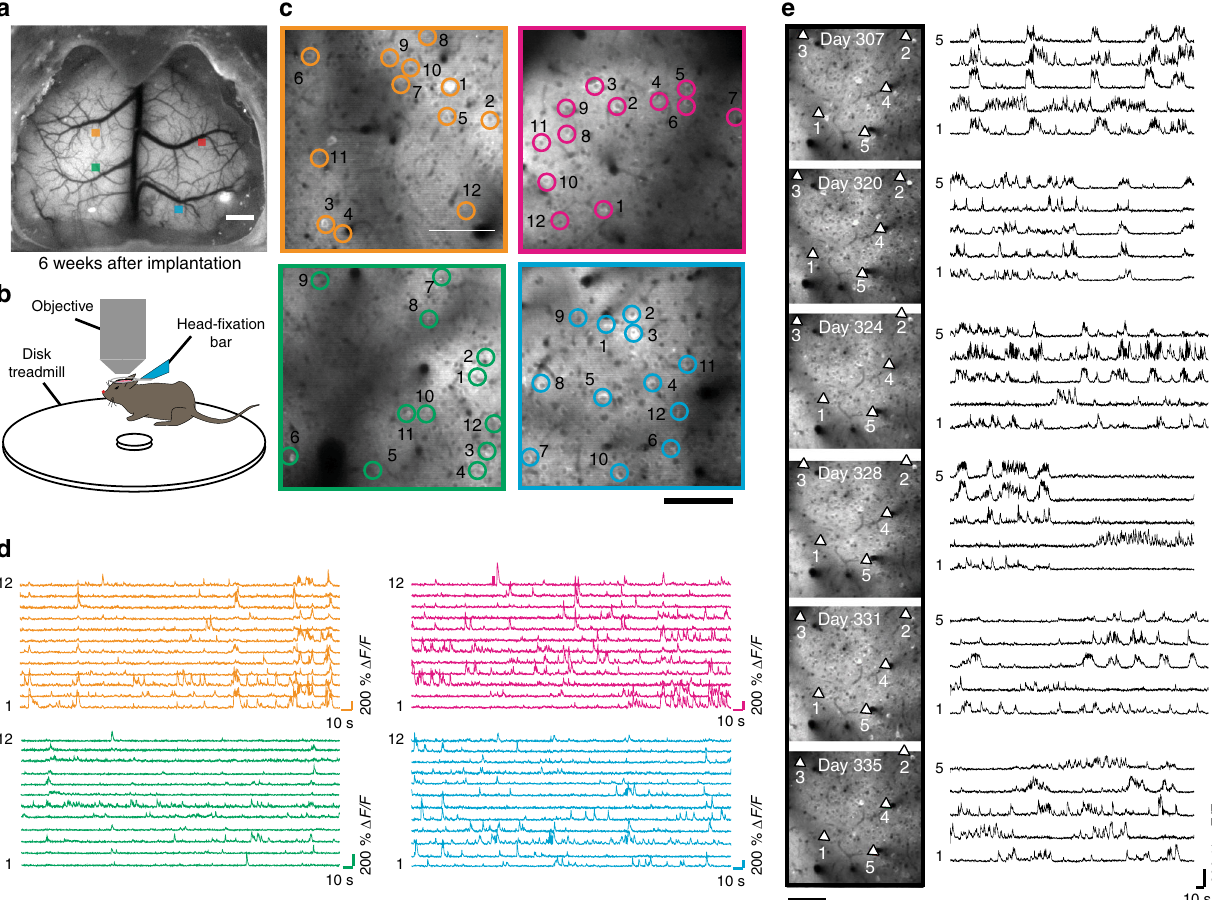
Fig. 4 Monitoring Ca 2 + activities in awake head- fi xed mice. a Wide- fi eld image of a Thy1-GCaMP6f mouse implanted with a See-Shell taken 6 weeks after implantation. Four locations indicated by the colored blocks were imaged using a 2P microscope. Scale bar indicates 1 mm. b Schematic of the mouse on the custom-designed disk treadmill used for 2P imaging. c Average intensity images calculated from 5-min time series acquired 200 – 300 µ m deep from pial surface. Scale bar indicates 100 µ m. d Color-coded time series of Ca 2 + activities of neurons identi fi ed and annotated by open circles in the respective average intensity images in c . e Time lapse Ca 2 + imaging: Left: Average intensity images calculated from 5 min time series acquired from the same fi eld of view in a See-Shell-implanted Thy1-GCaMP6f mouse in six separate imaging sessions. Activities of individual neurons, indicated by arrows, are shown in the right. Scale bar indicates 100 µ